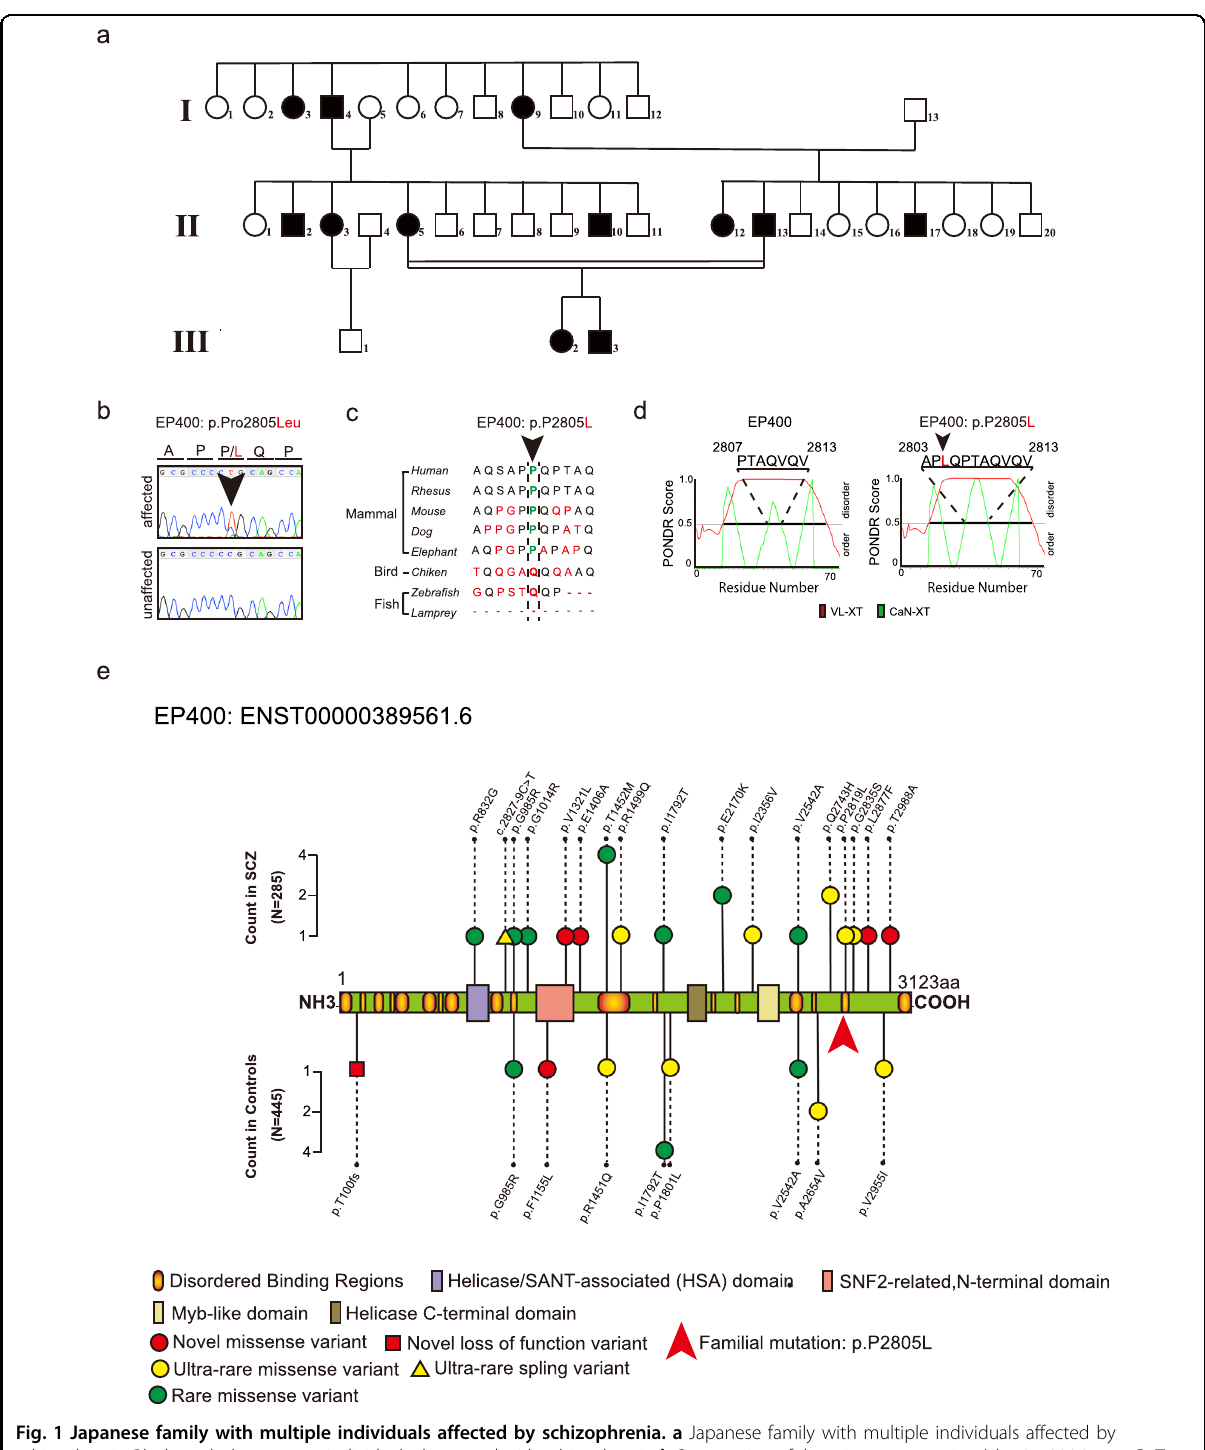
Fig. 1 Japanese family with multiple individuals affected by schizophrenia. a Japanese family with multiple individuals affected by schizophrenia. Black symbols represent individuals diagnosed with schizophrenia. b Segregation of the missense mutation (chr12: 132064747; C>T on hg38, p.P2805L in ENST00000389561.7) in EP400 with schizophrenia. c The position of the familial missense mutation in the EP400 gene. d The CaN-XT algorithm in PONDR was used to predict the effect of p.P2805L on the EP400 protein. e EP400 deleterious variants in Japanese individuals with or without schizophrenia. Rare variants are represented by lollipops, and counts of alleles with variants in the cases (top panel) and controls (bottom panel) are shown. Novel variant = novel variant in all databases; ultra-rare variant = variants with MAF < 0.001 in any database; rare variant = variants with 0.001 < MAF < 0.005 in any